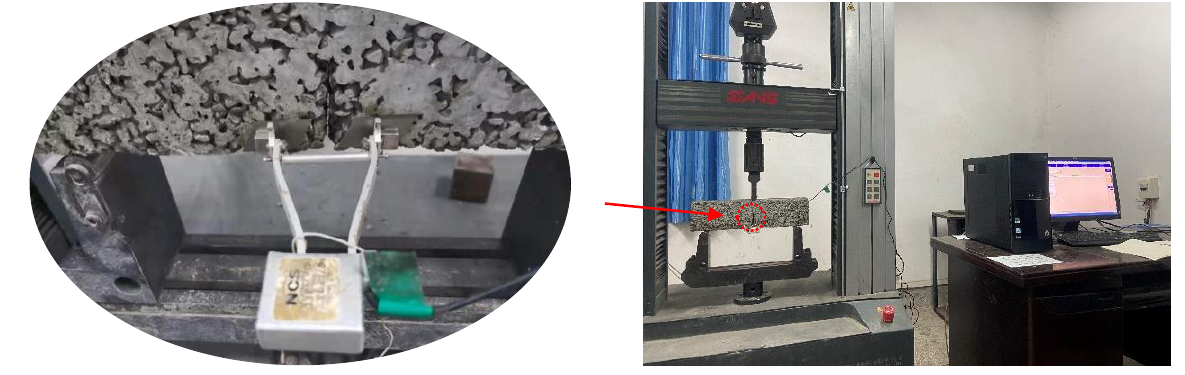
Figure 6. Fracture toughness test illustration.